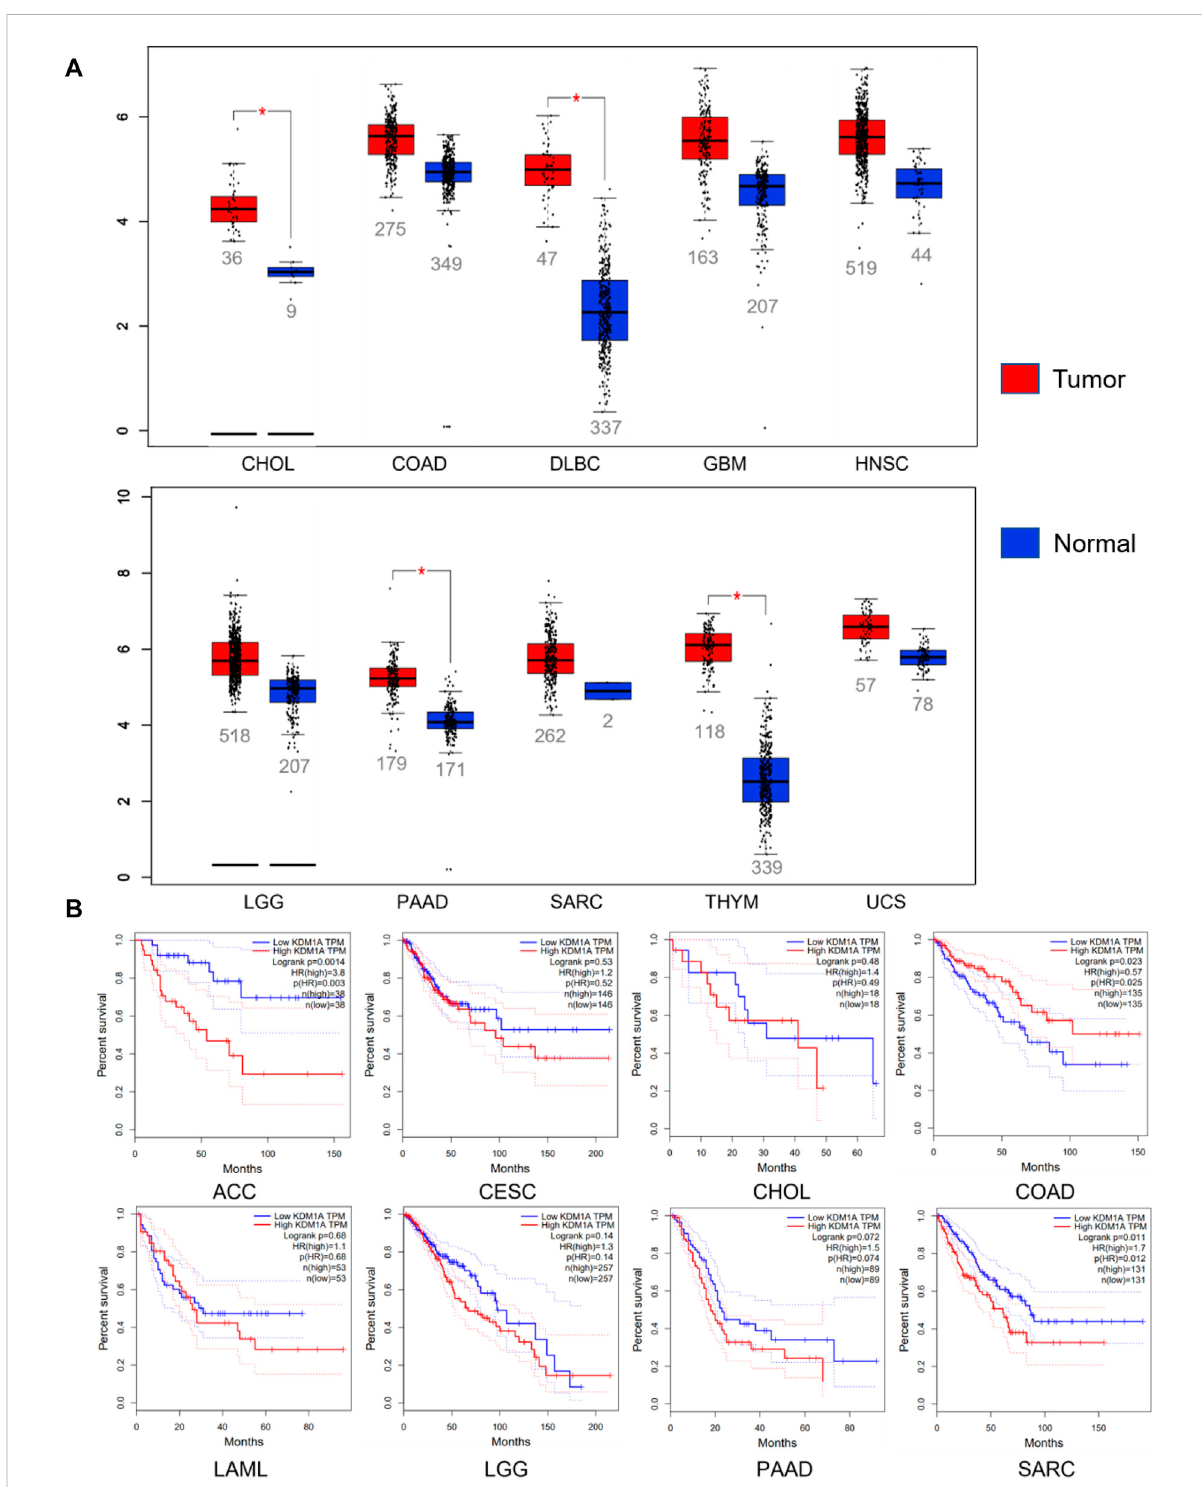
FIGURE 3 Relationship between LSD1 and cancers. (A) LSD1 is aberrantly expressed in various cancers. (B) Analysis of the correlation between LSD1 expression and overall survival (OS). Data from the GEPIA database,